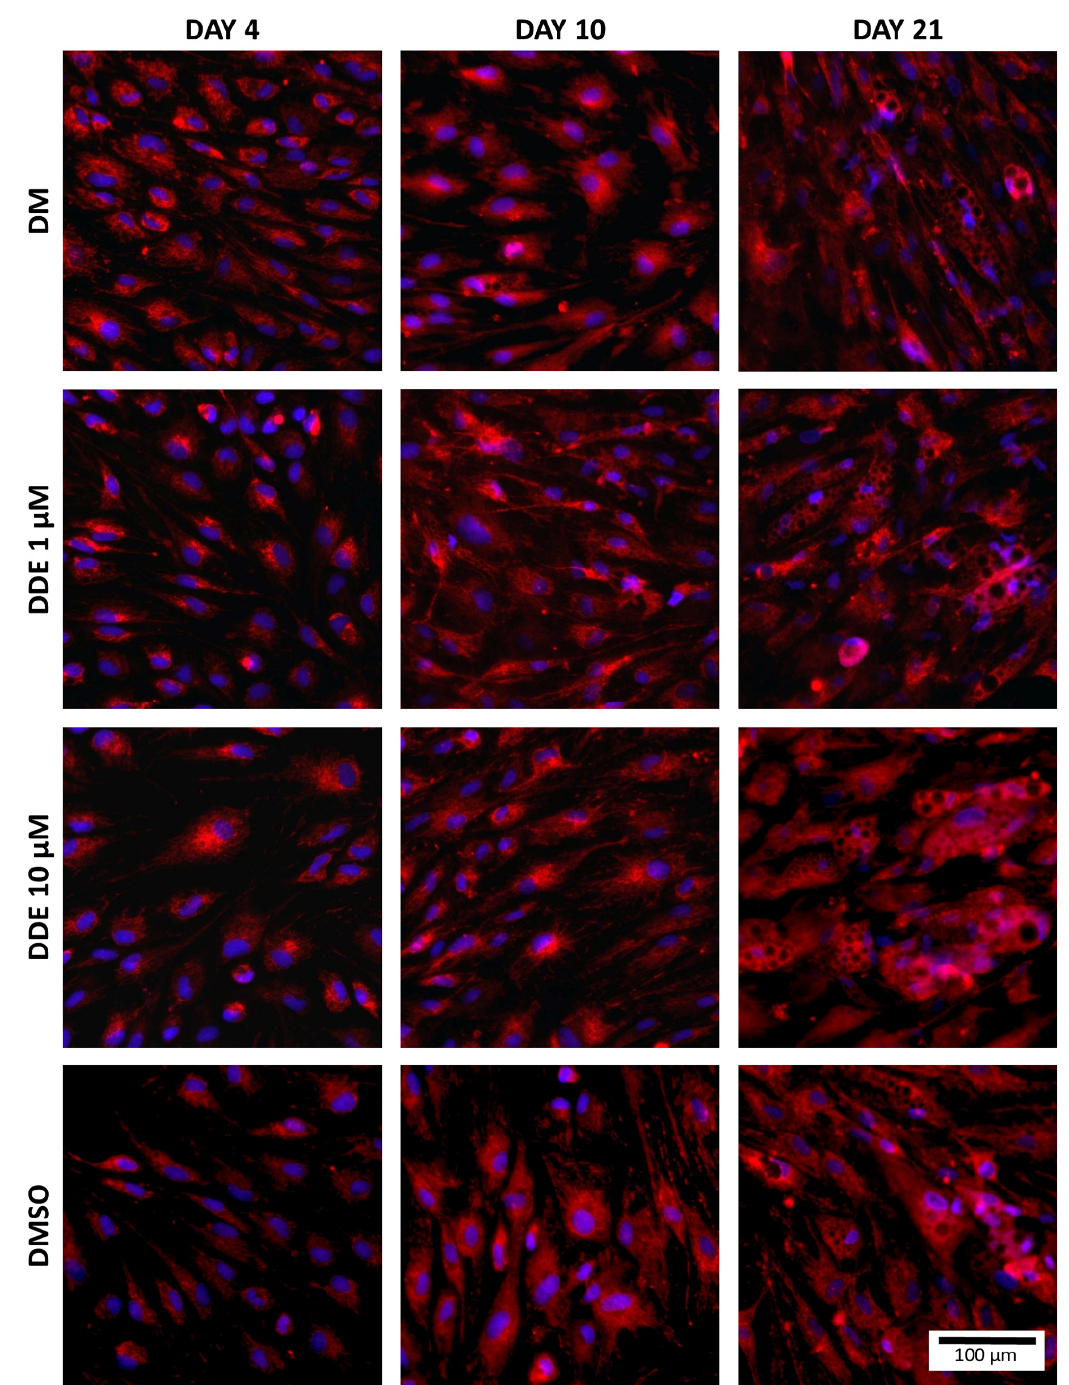
Figure 4. Staining of mitochondria (red) and nuclei (blue) in each environment (fluorescent probes, MitoTracker TM Red CMXRos and NucBlue TM Live ReadyProbes Reagent were used to visualize the mitochondria and nucleus of cells).